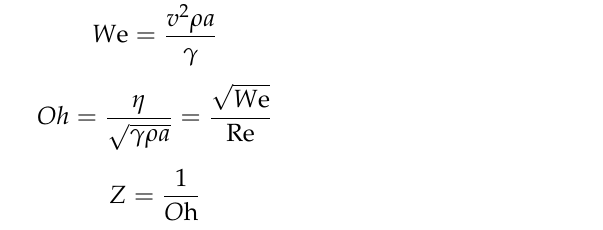
Calculation of Weber number representing the ratio of inertial force to surface tension effect: